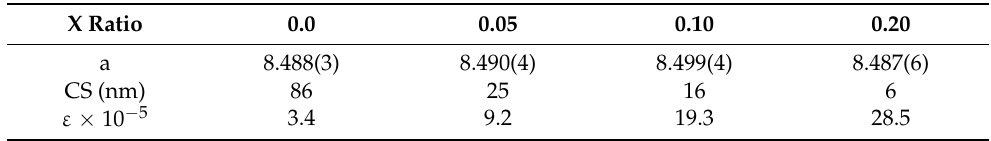
Figure 2. XRD patterns of MnFe 2-1.67x V x O 4 spinel ferrites. Table 1. Refined values of cell parameters a (Å), average crystallite size CS (nm) and average mi- crostrain ( µ ε ).